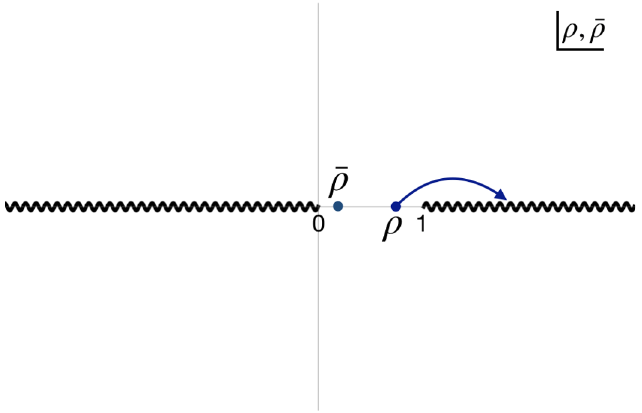
Figure 3 . Analytic structure of the correlator (3.2) — branch cuts appear only when two operators become null separated. The Regge limit is obtained from the Euclidean correlator by analytically continuing ρ along the path